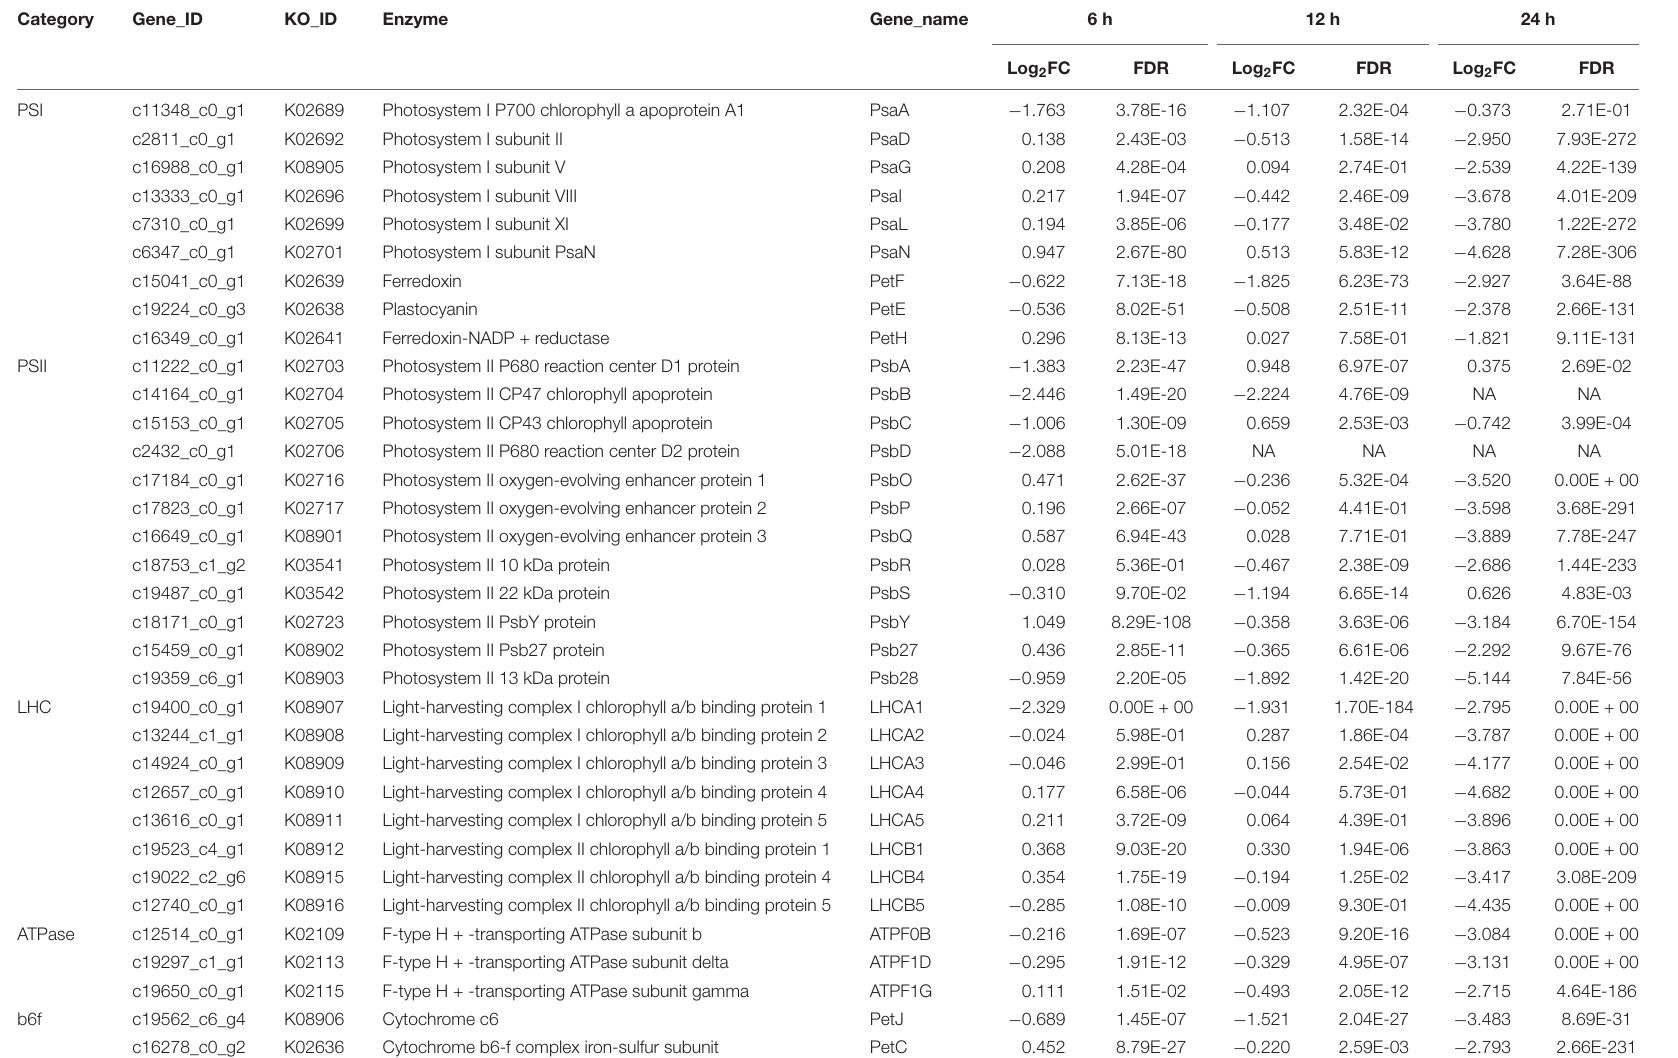
TABLE 1 | Comparative transcriptomic analysis of photosynthesis for the heterotrophically grown S. acuminatus cells subjected to the high light and N-limited conditions.